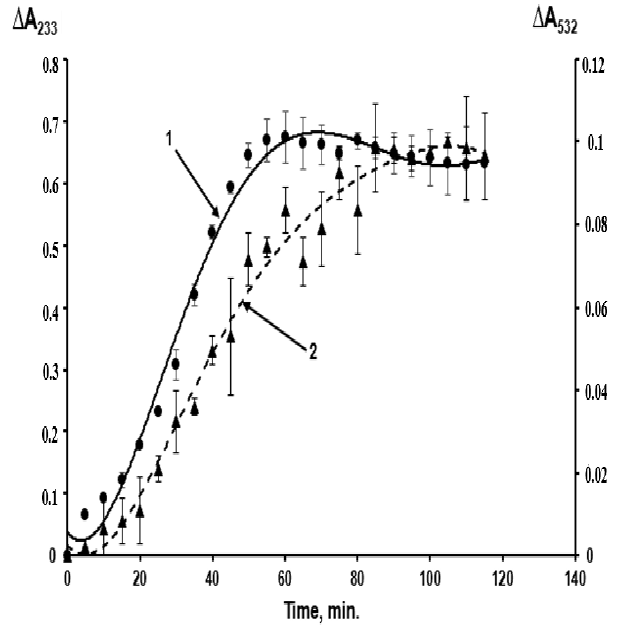
Figure 2. Kinetics of free radical peroxidation of phospholipids of the outer layer of LDL particles isolated from blood plasma of a healthy donor initiated by copper ions, studied by the accumulation of primary—LOOH (curve 1, left scale — ∆ A 233 ) and secondary—MDA (curve 2, right scale — ∆ A 532 ) products of lipoperoxidation. The determination of lipoperoxides and MDA was carried out as described in [2].